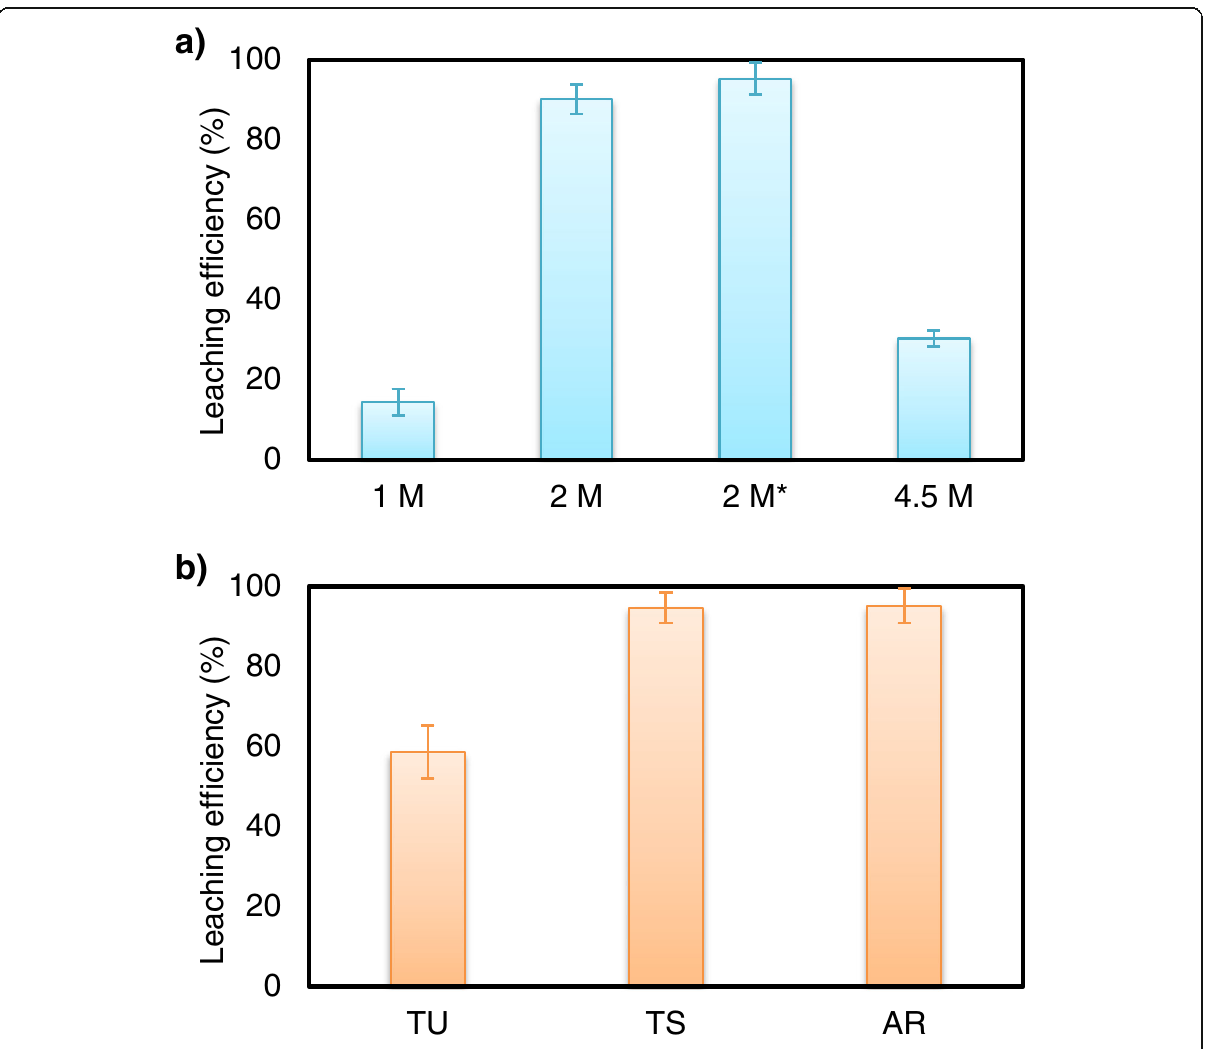
Fig. 2 Leaching efficiencies of ( A ) copper by using different concentrations of sulfuric acid and ( B ) gold by using thiourea (TU), thiosulfate (TS) and aqua regia (AR). The asterisk symbol represents that the lixiviant was a mixture of sulfuric acid and hydrogen